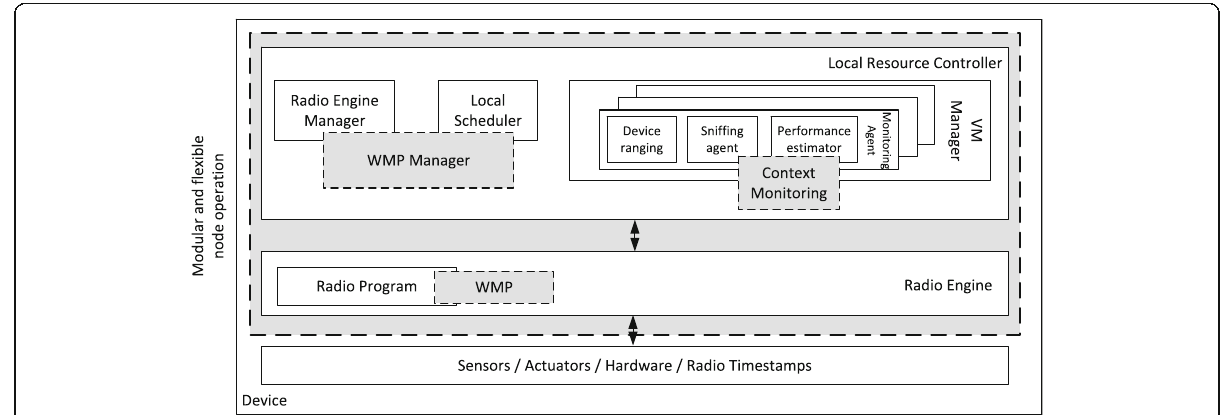
Fig. 4 Placement of the reconfigurable radio platform functions within the reference architecture of Section